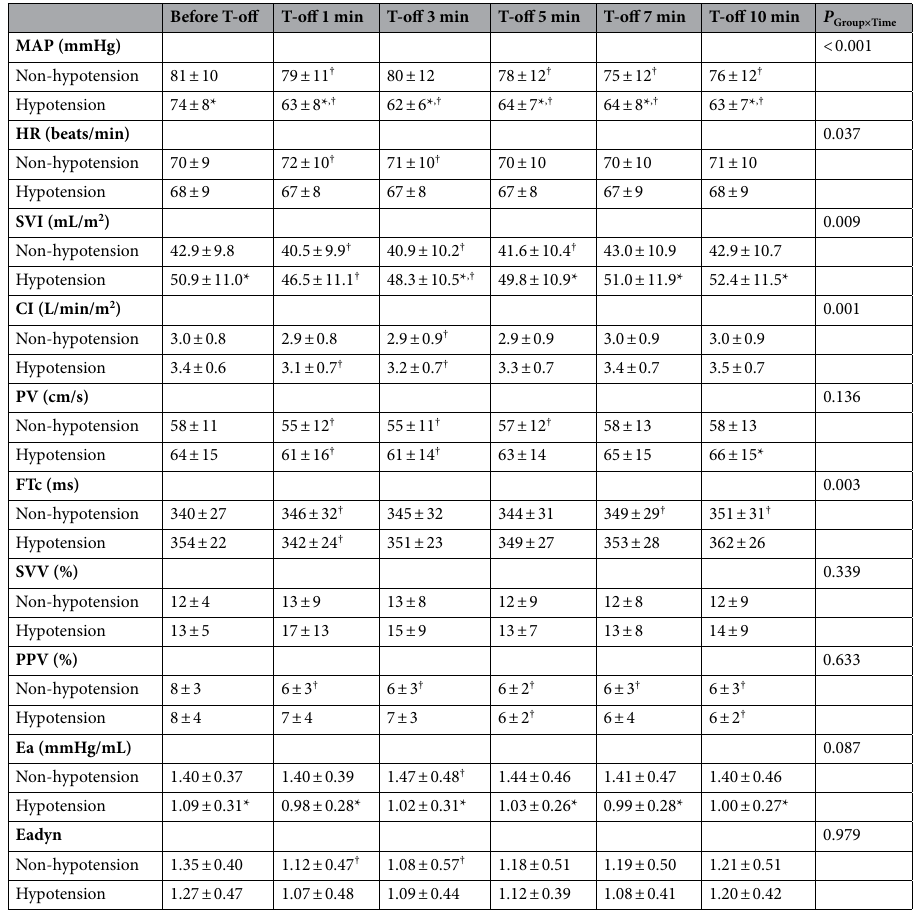
Table 2. Changes in hemodynamic variables. Values are presented as mean ± standard deviation. T-off positional change from the Trendelenburg position to the supine position; MAP mean arterial pressure; HR heart rate; SVI stroke volume index; CI cardiac index; PV peak velocity; FTc corrected flow time; SVV stroke volume variation; PPV pulse pressure variation; Ea arterial elastance, calculated as (systolic arterial pressure × 0.9)/stroke volume; Eadyn dynamic arterial elastance, calculated as SVV/PPV. P Group×Time , P value of the group and time interaction obtained by linear mixed model analysis. *Bonferroni-corrected P < 0.05 compared with the non-hypotension group. † Bonferroni-corrected P < 0.05 compared with the value of “before T-off” in each group.